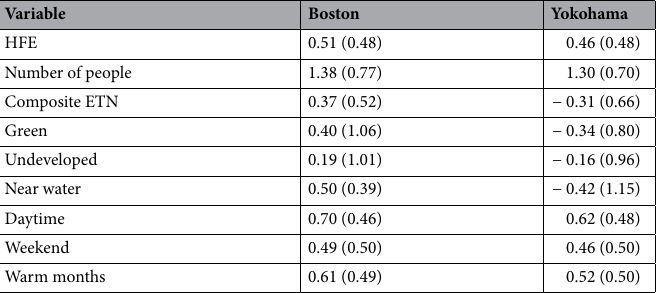
Table 1. Means and standard deviations of the dependent variable (HFE) and the independent variables in Boston and Yokohama. Note that the "Composite ETN", "Green", "Undeveloped" and "Near water" variables were scaled to mean 0 and standard deviation of 1 according to their distribution in both study areas combined . The fact that the means of those four variables were positive in Boston and negative in Yokohama therefore means that Yokohama was characterized by relatively lower naturalness compared to